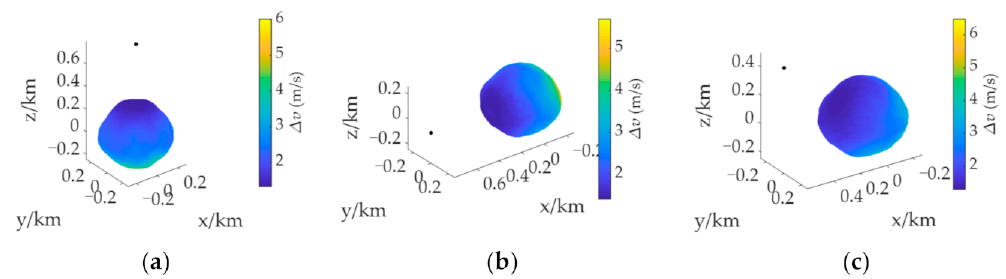
Figure 4. Distribution of velocity increment with different initial positions at t f = 1200 s. ( a ) Over the North Pole. ( b ) Over the Equator. ( c ) Over the mid-latitude